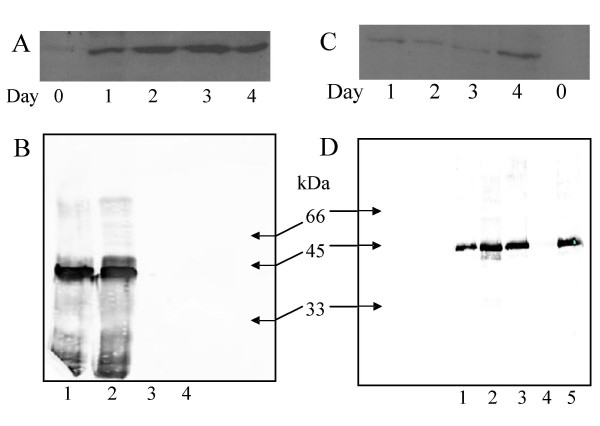
Expression of rF6Hy/rF6Hys as detected by immunoblotting using anti-His antibody (A) Time course induction of rF6Hy. (B) Purification of rF6Hy on Ni-NTA. Lanes: 1, Bound 2 (2 mL eluate; 5 μg); 2, Bound 1 (1 ml eluate; 5 μg); 3, wash (10 μg); 4, flow-through (10 μg). (C) Time course induction of rF6Hys. (D) Purification of rF6Hys on Ni-NTA. Lanes: 1, Bound 3 (3 mL eluate; 2 μg); 2, Bound 2 (2 mL eluate; 2 μg); 3, Bound 1 (1 mL eluate; 5 μg); 4, wash (10 μg); 5, flow-through (10 μg).